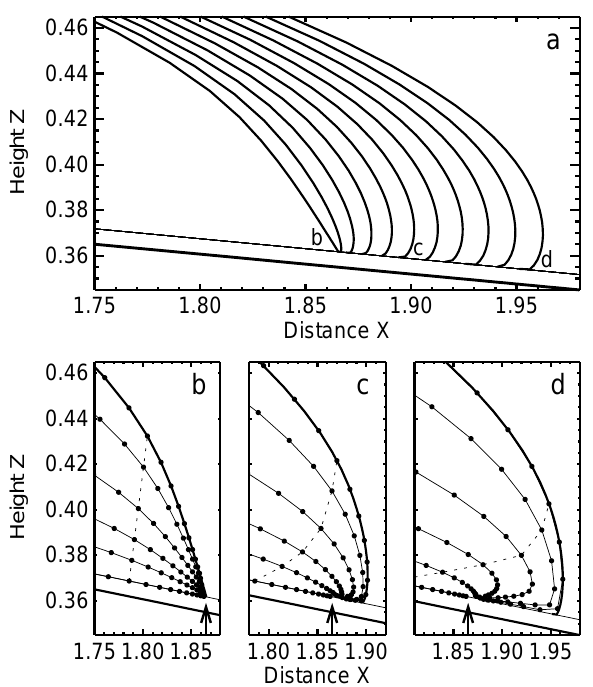
Fig. 2. Experiment A: Relatively stiff and moderately non-linear till ( m =3 , B =8 ): (a) glacier surfaces are shown at time intervals of approximately two dimensionless time units. Selected front positions and surface shapes marked (b) , (c) and (d) are shown in more detail in subfigures (b–d). (b–d) snapshots of the front showing the surface, four selected internal layers and the ice-sediment interface at dimensionless times T equal to 0 (b), 10 (c) and 20 (d). The dots indicate material particles that can be followed throughout the three pictures. The connecting lines illustrate how material layers (fine solid and dashed lines) with initial shape as in (b) become deformed with time. The arrow marks the initial position of the glacier front.